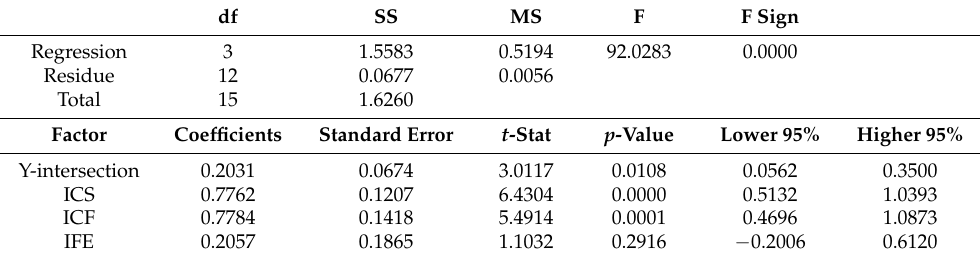
Table 8. Multiple regression model results for textile companies under study based on integrated capital structure (ICS), integrated current financing (ICF) and integrated financial efficiency (IFE). df SS MS F F Sign Regression